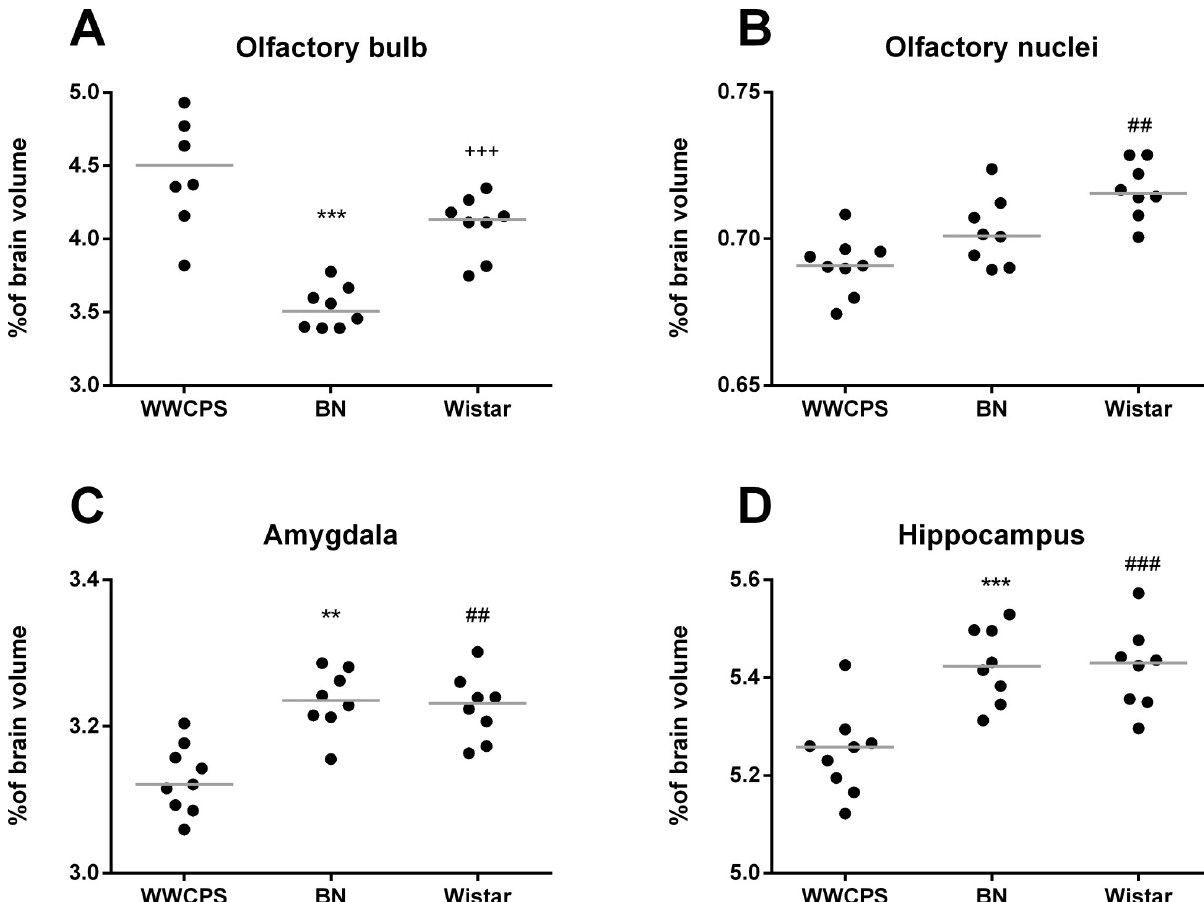
Fig 6. Relative volumes of brain structures (normalized to individual brain volumes) in WWCPS, BN and Wistar rats. Lines represent medians, dots represent individual values. (A) The olfactory bulbs, (B) olfactory nuclei, (C) amygdala and (D) hippocampus. The olfactory bulbs were segmented manually and the other structures were segmented automatically. Symbols represent Bonferroni corrected significance levels: �� p < 0.003, ��� p < 0.0003 BN vs. WWCPS; ## p < 0.003, ### p < 0.0003 Wistar vs. WWCPS; +++ p < 0.0.0003 BN vs. Wistar.